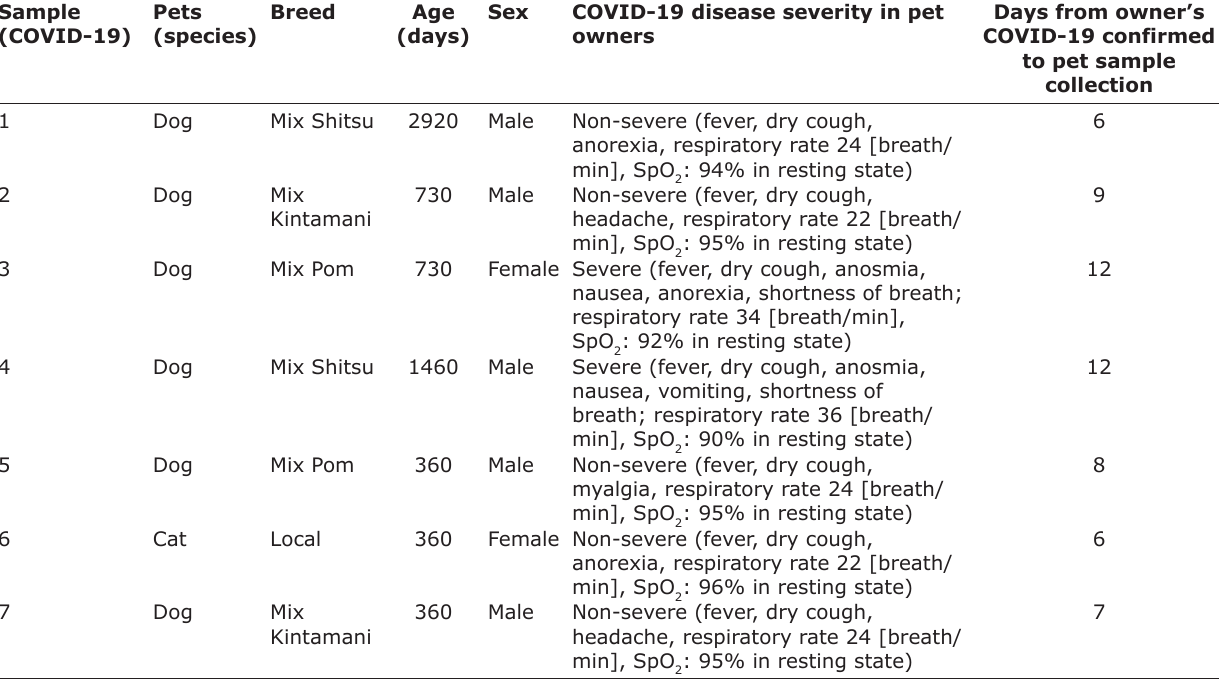
Table-1: Characteristics of pets screened for SARS-CoV-2 living with owners who confirmed positive with COVID-19. Sample Pets Breed (COVID-19) (species)